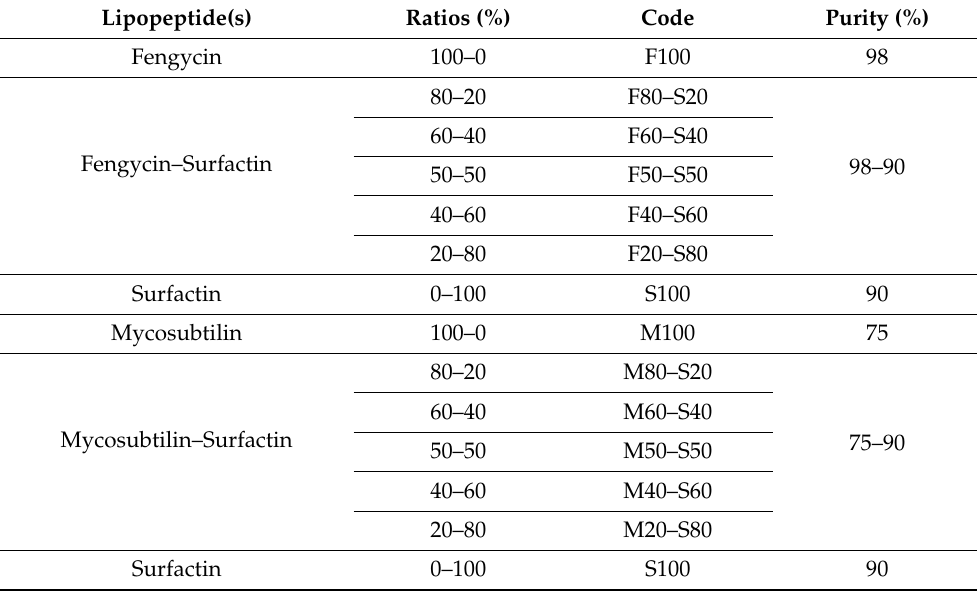
Table 1. Lipopeptides used in this study, their ratios and purity.